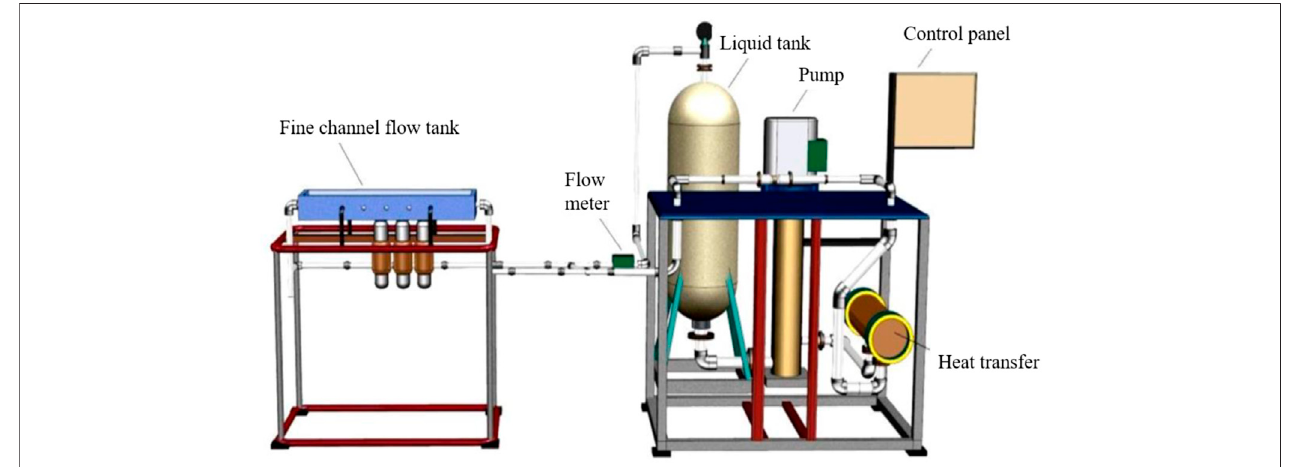
FIGURE 3 | Overall schematic diagram of the scouring test device.